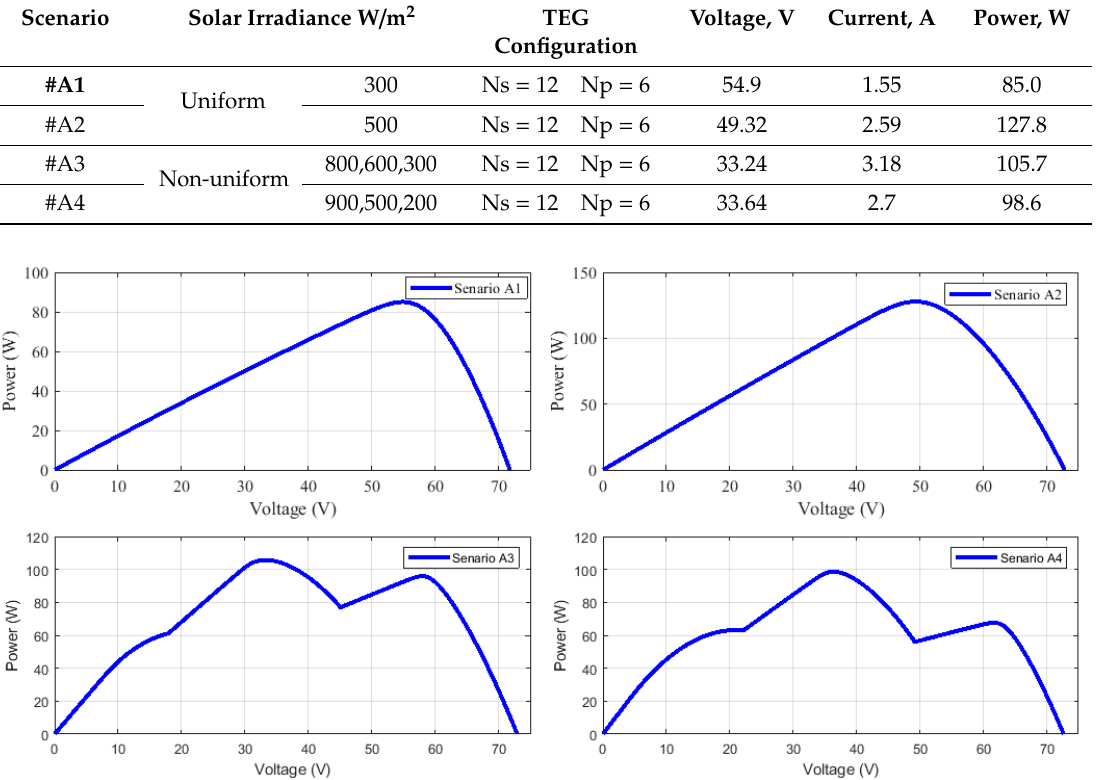
Figure A2. The performance of HPVTEG under different scenarios.